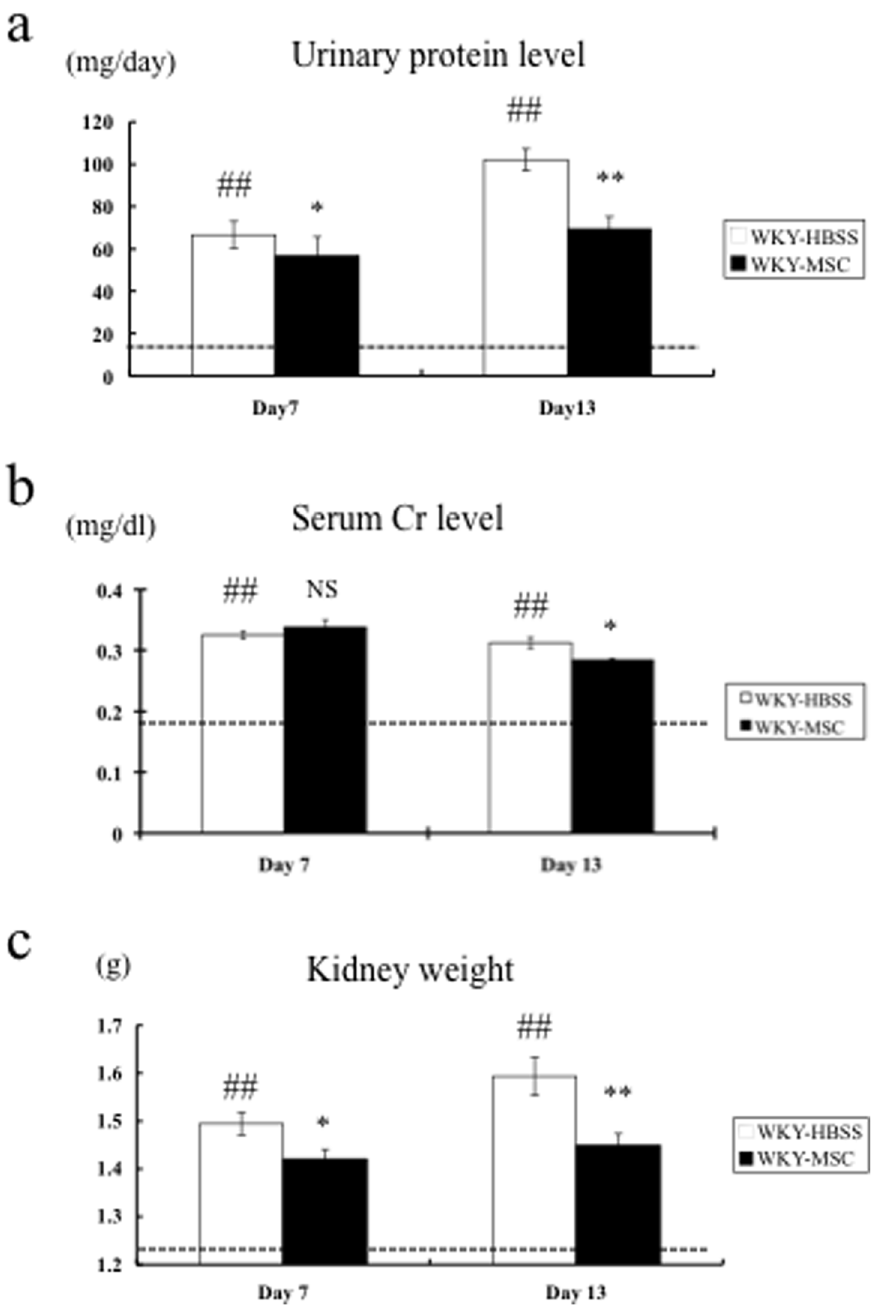
Figure 1 . Urinary total protein level, serum creatinine level, and total kidney weight in the study groups. ( a ) Urinary total protein level, ( b ) serum creatinine level, and ( c ) total kidney weight of WKY rats with nephritis treated with either HBSS (WKY-HBSS) or MSC (WKY-MSC) are shown. The horizontal dotted lines show the level of proteinuria, serum creatinine, and kidney weight in WKY rats without nephritis (WKY-NTS (-)). Data are means 6 SEM. NS, *p , 0.05, **p , 0.01: HBSS-treated rats with nephritis vs. MSC-treated rat with nephritis; ## p , 0.01: HBSS-treated rats with nephritis vs. WKY rats without nephritis. NS, not significant.